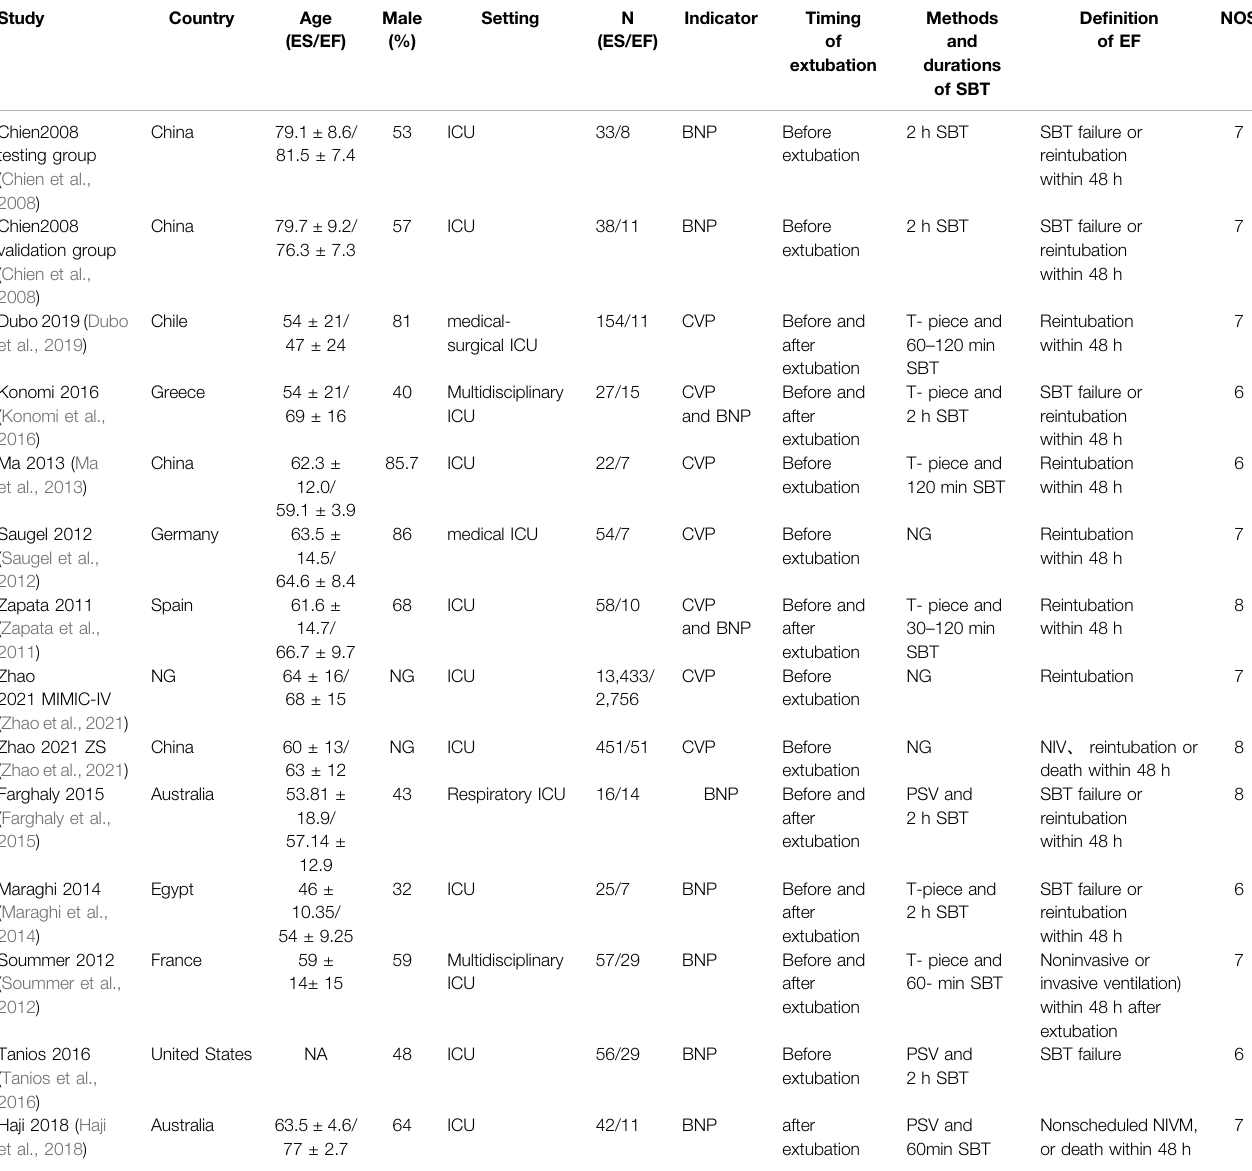
TABLE 1 | Characteristics of